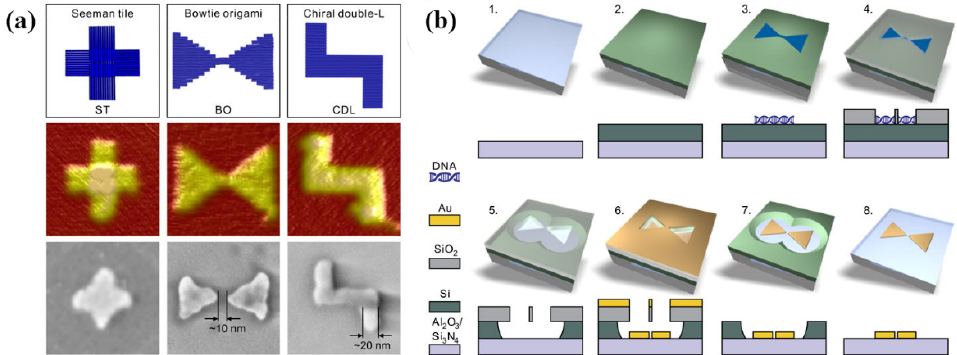
Figure 7. DNA origami designs and its fabricating process based on DNA ‐ Assisted Lithography (DALI). ( a ) Designed three plasmonic structures prepared by DALI and their AFM image and SEM image. ( b ) The procedure of manufacturing bowtie origami. Reproduced with permission from reference [62]. Copyright 2018 American Association for the Advancement of Science.